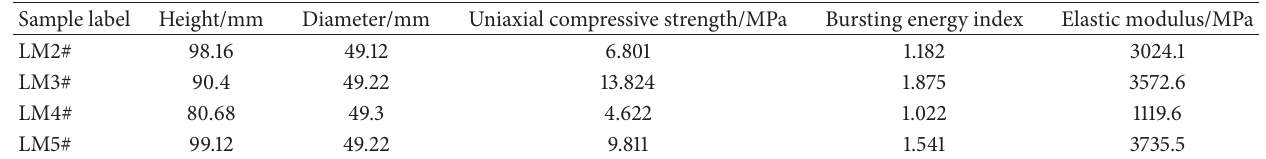
Table 1: Physical and mechanical parameters of 4 coal samples.